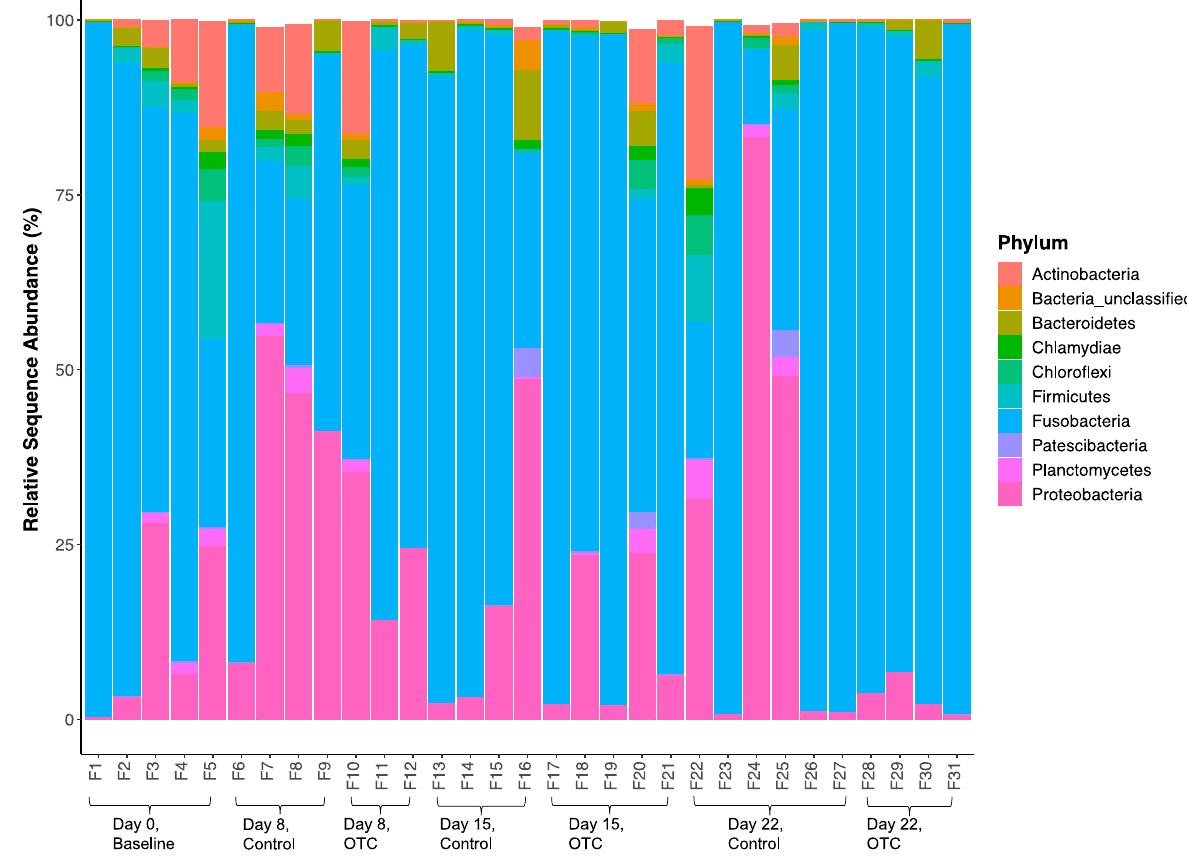
Figure 4. Relative sequence abundance (%) of the top 10 bacterial phyla in the distal gut of control or oxytetracycline (OTC) ‐ treated Nile tilapia before and after antibiotic treatment.